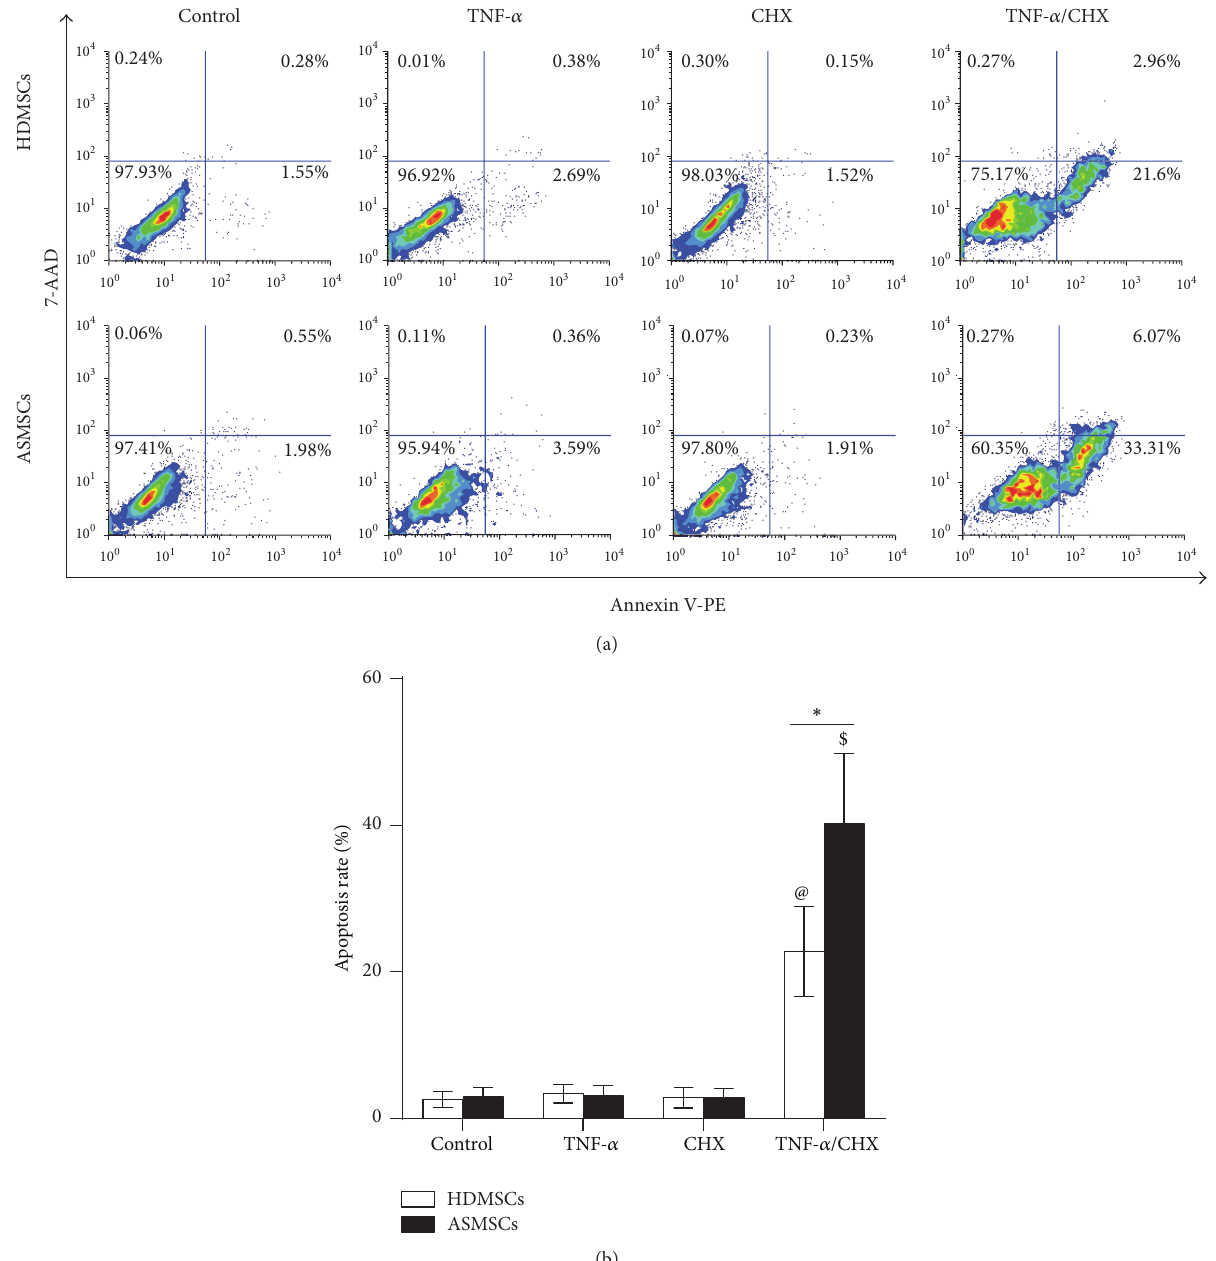
Figure 2: ASMSCs were more susceptible to TNF- 𝛼 /CHX-induced apoptosis compared to HDMSCs. (a) Apoptosis of HDMSCs ( 𝑛 = 28 ) and ASMSCs ( 𝑛 = 22 ) was determined using FCM. Cells in the upper-right and lower-right quadrants represent apoptotic cells; the apoptotic rate was calculated in (b). After a 6-hour culture, only treatment with TNF- 𝛼 /CHX induced significant MSC apoptosis. Treatment with control medium or with TNF- 𝛼 or CHX alone did not induce significant apoptosis. ASMSCs had a higher rate of apoptosis than HDMSCs in the TNF- 𝛼 /CHX treatment group. Values are presented as the mean ± SD. ∗ indicates 𝑃 < 0.05 between HDMSCs and ASMSCs. @ indicates 𝑃 < 0.05 for the control group compared with the other HDMSC groups. $ indicates 𝑃 < 0.05 for the control group compared with the other ASMSC